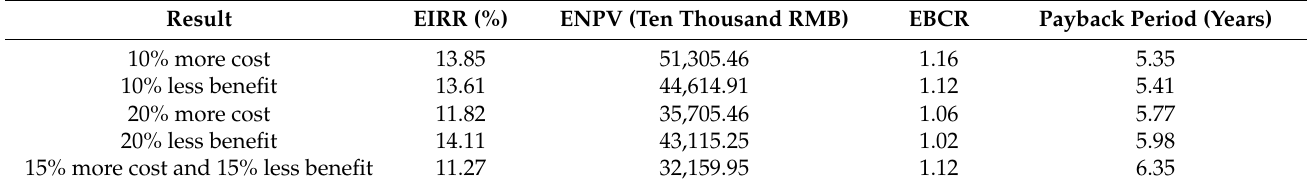
Table 8. National economic evaluation results (High cost).